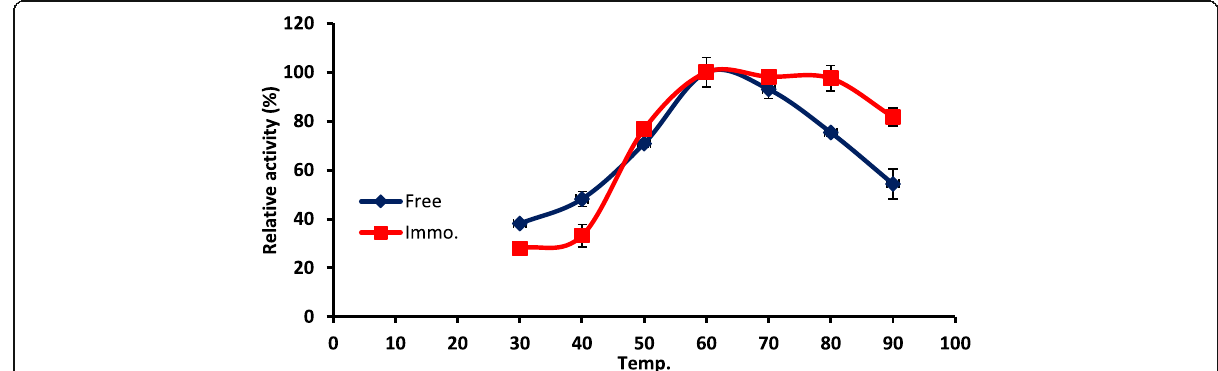
Fig. 8 Optimum temperature for free and covalently immobilized glucoamylase enzyme onto activated gel beads